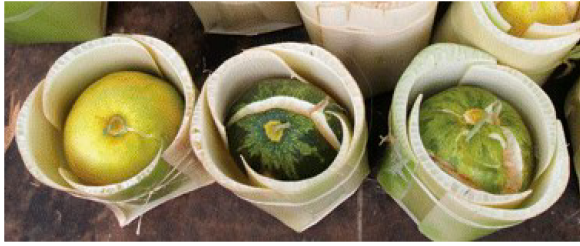
Figure 1 Cucumis melo packaged in banana